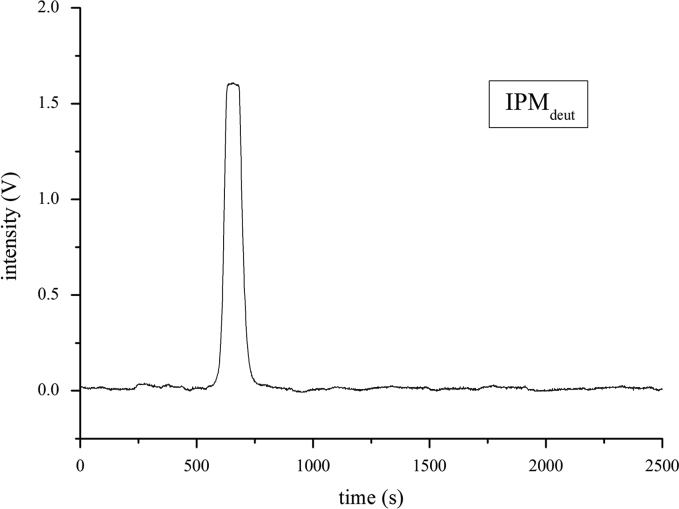
HPLC chromatogram of the purified IPMdeut.